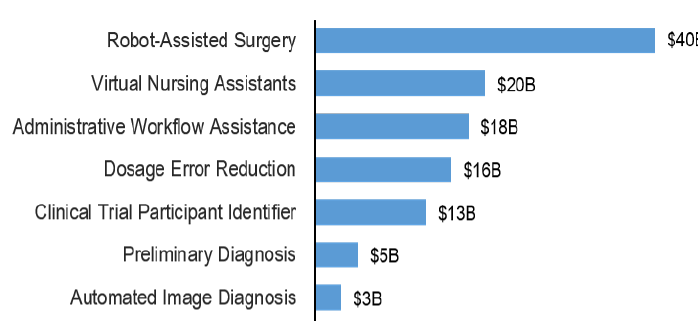
Figure 10. AI healthcare applications with the greatest impact on the economy (Adapted from: